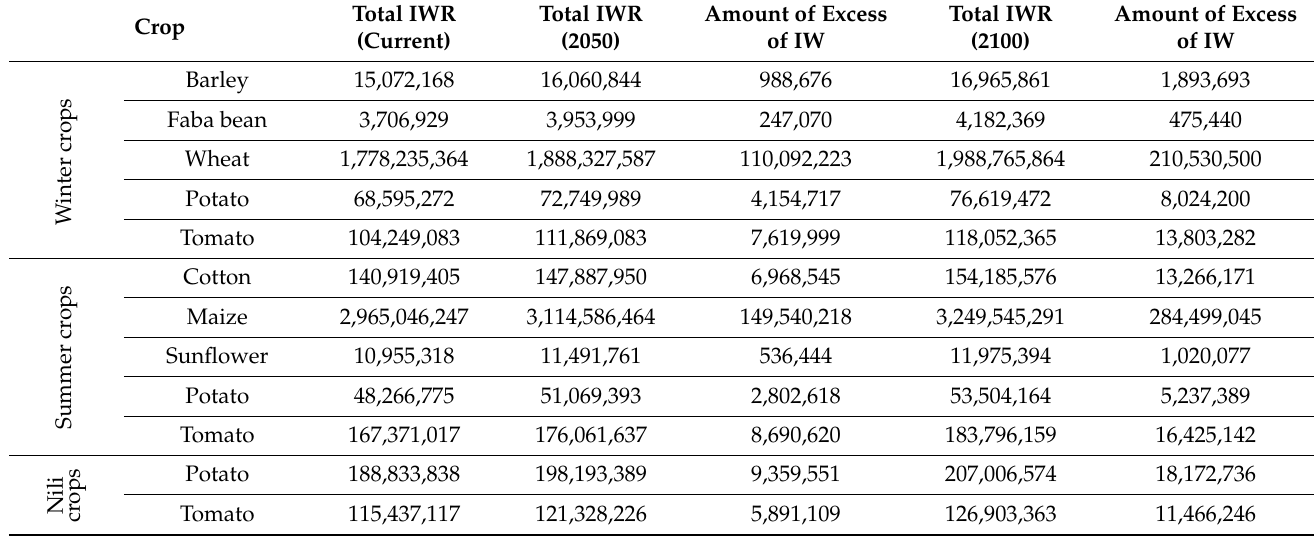
Table 3. Increase required in irrigation water under the conditions of future climatic changes compared to current irrigation water amounts according to the total cropped area in